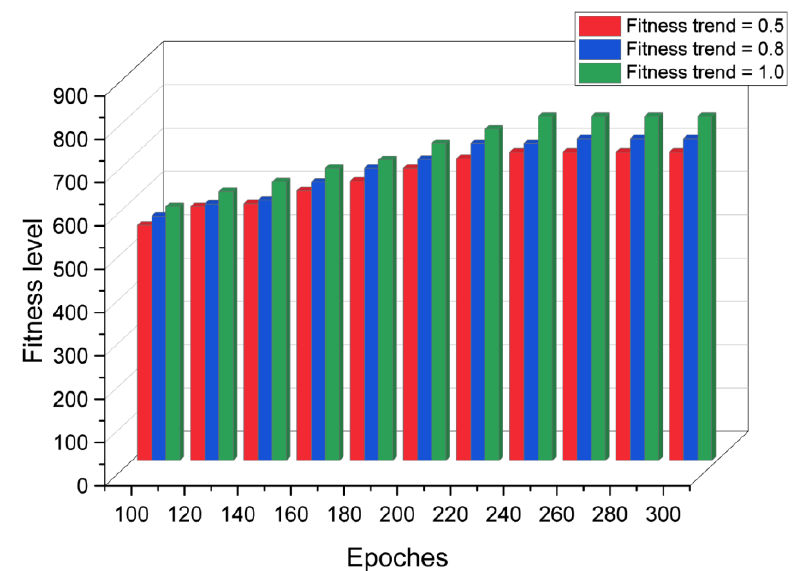
Figure 6. Fitness level evaluation. Table 1. The energy consumption (J) of the proposed IoT-SCOM.